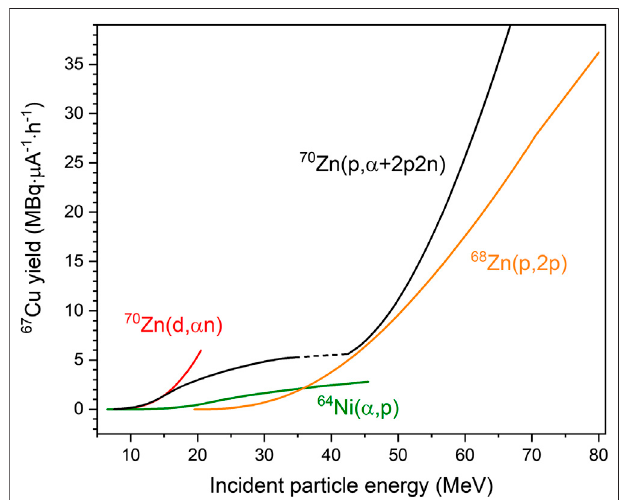
FIGURE 1 | Integral yield of 67 Cu, calculated from the excitation function of each reaction for an irradiation time of 1 h, shown as a function of incident particle energy. The dashed part of the curve for the 70 Zn(p,x) 67 Cu process is an extrapolation because no data